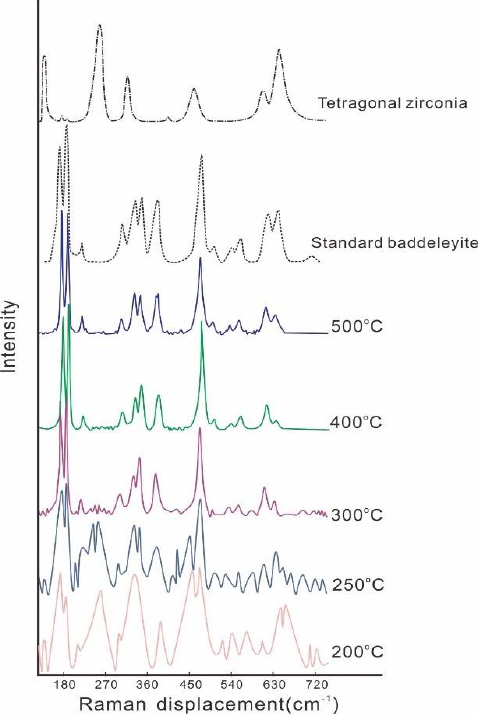
Figure 2. Raman spectra of zirconia micro-nanoflakes synthesized in the present study and standard monoclinic (e.g., baddeleyite) and tetragonal zirconia (ZrO 2 ) crystals. The standard Raman spectrum of baddeleyite is derived from an online Raman database (https://rruff.info/baddeleyite/display=default/R060016 (accessed on 8 May 2021), while the Raman spectrum of tetragonal zirconia (ZrO 2 ) is from Reference [45].